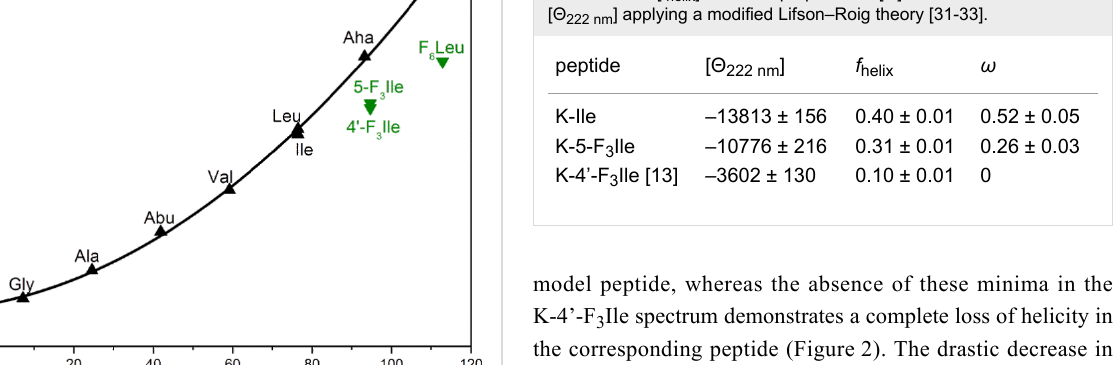
Table 1: Ellipticity [ Θ ] at 222 nm was taken from normalized CD data. Fraction helix [f helix ] and helix propensities [ ω ] were calculated from